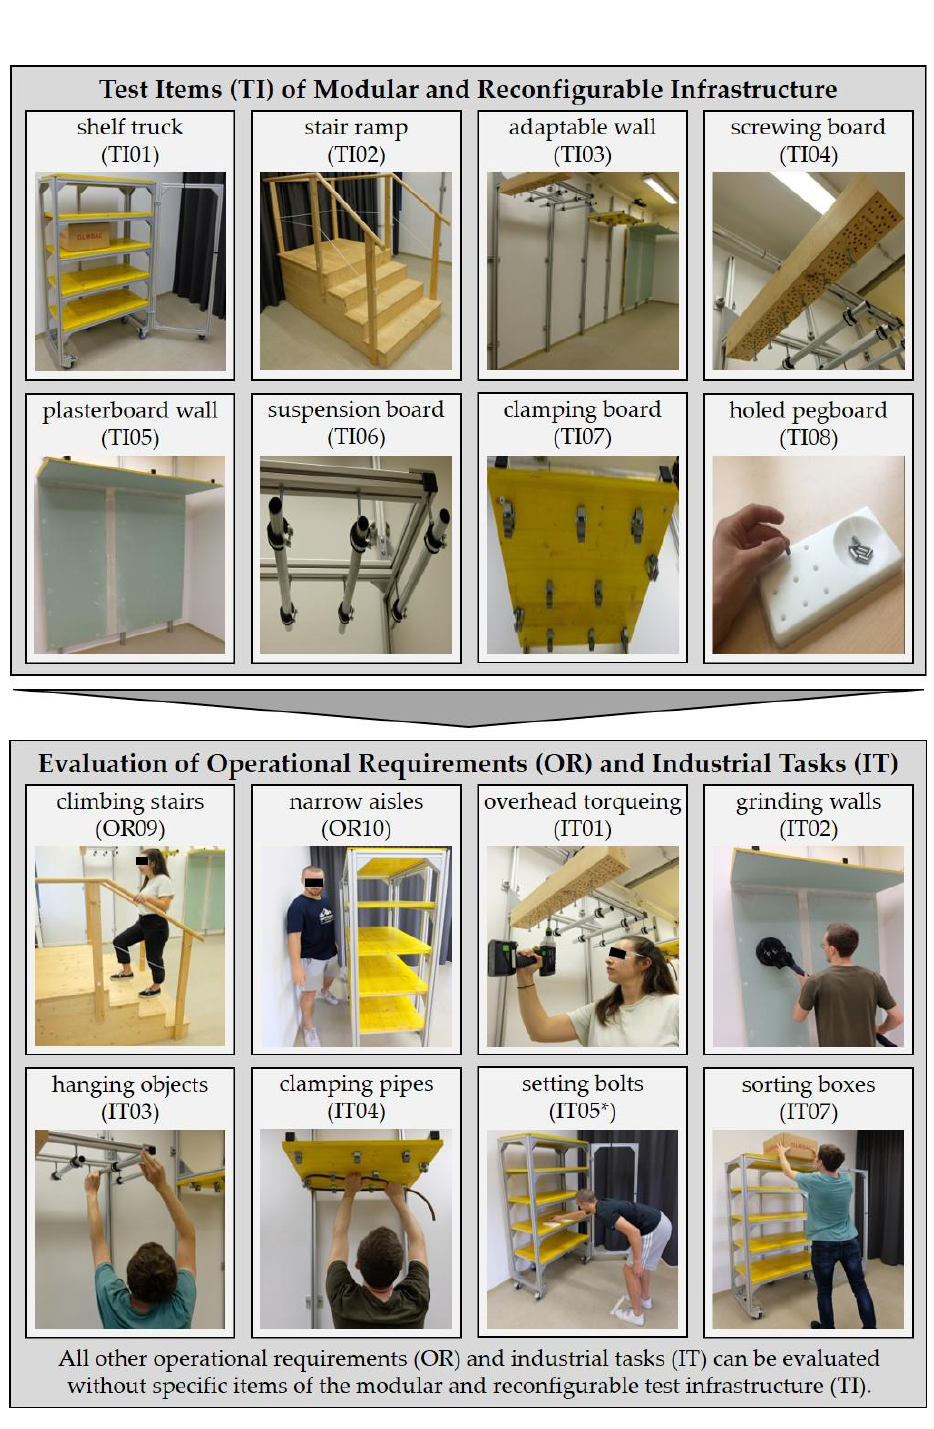
Figure 4. Items of test course infrastructure with exemplary arrangements and applications for the evaluation of operational requirements and industrial tasks (baseline scenario).